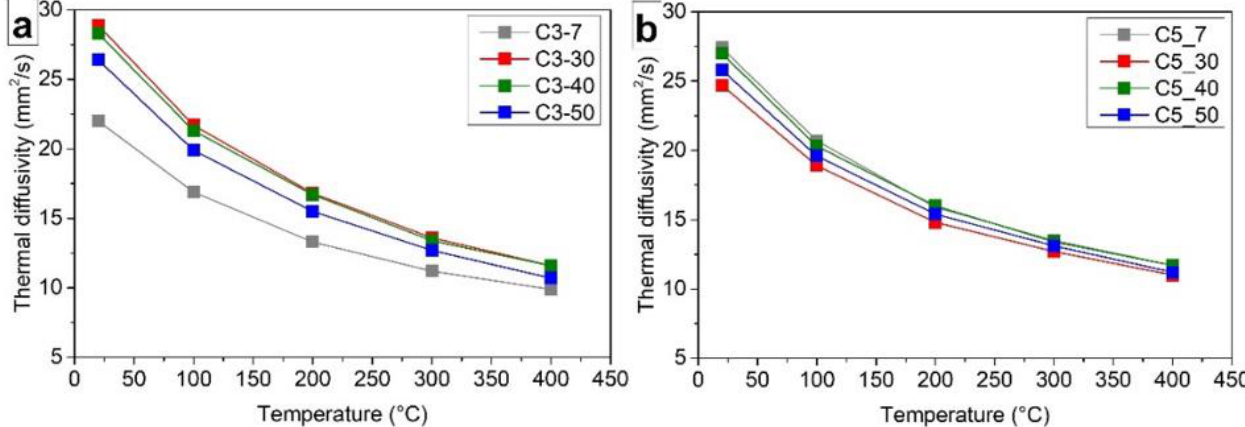
Figure 6. Thermal diffusivities of ( a ) 3-layered and ( b ) 5-layered SiC/GNP composites sintered under different pressures (7, 30, 40, and 50 MPa).